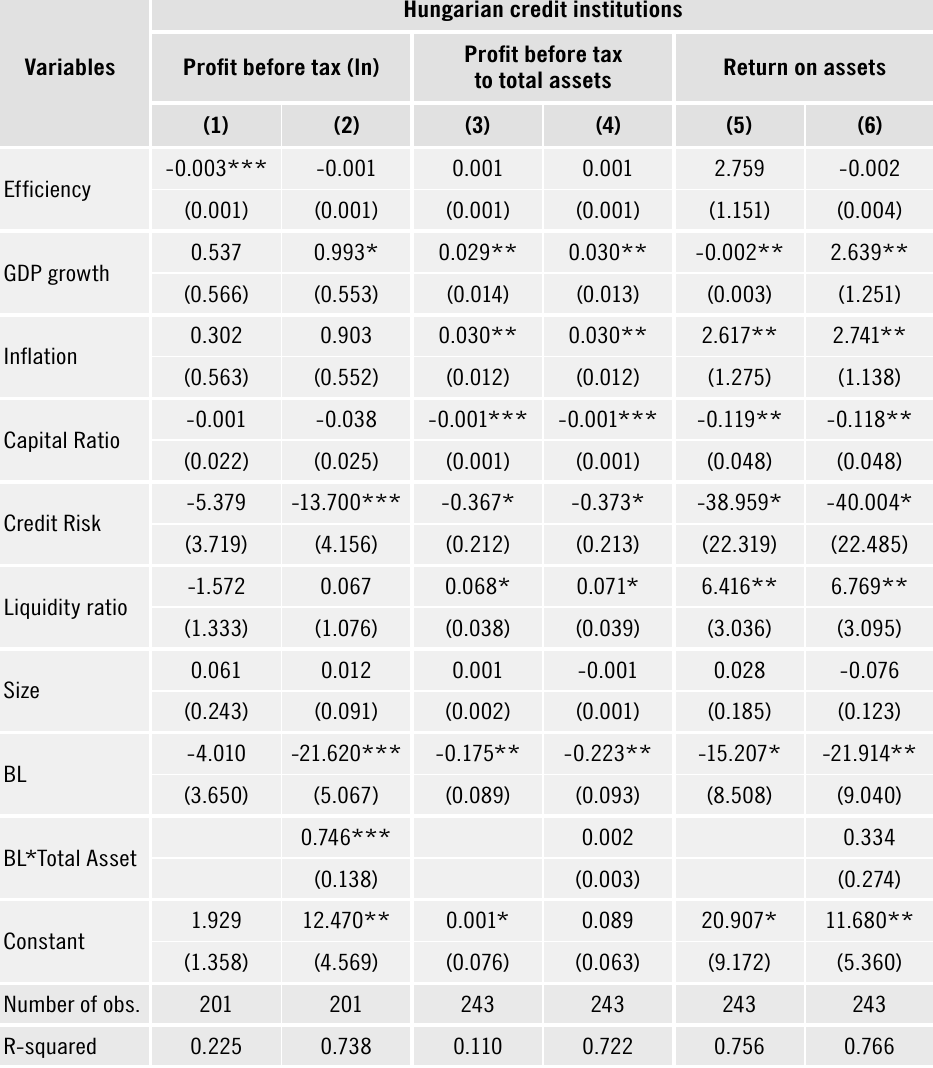
Table 4. Data presenting estimates based on GLS regressions with a random effect on Hungarian credit institutions appear as one-year lagged variables in